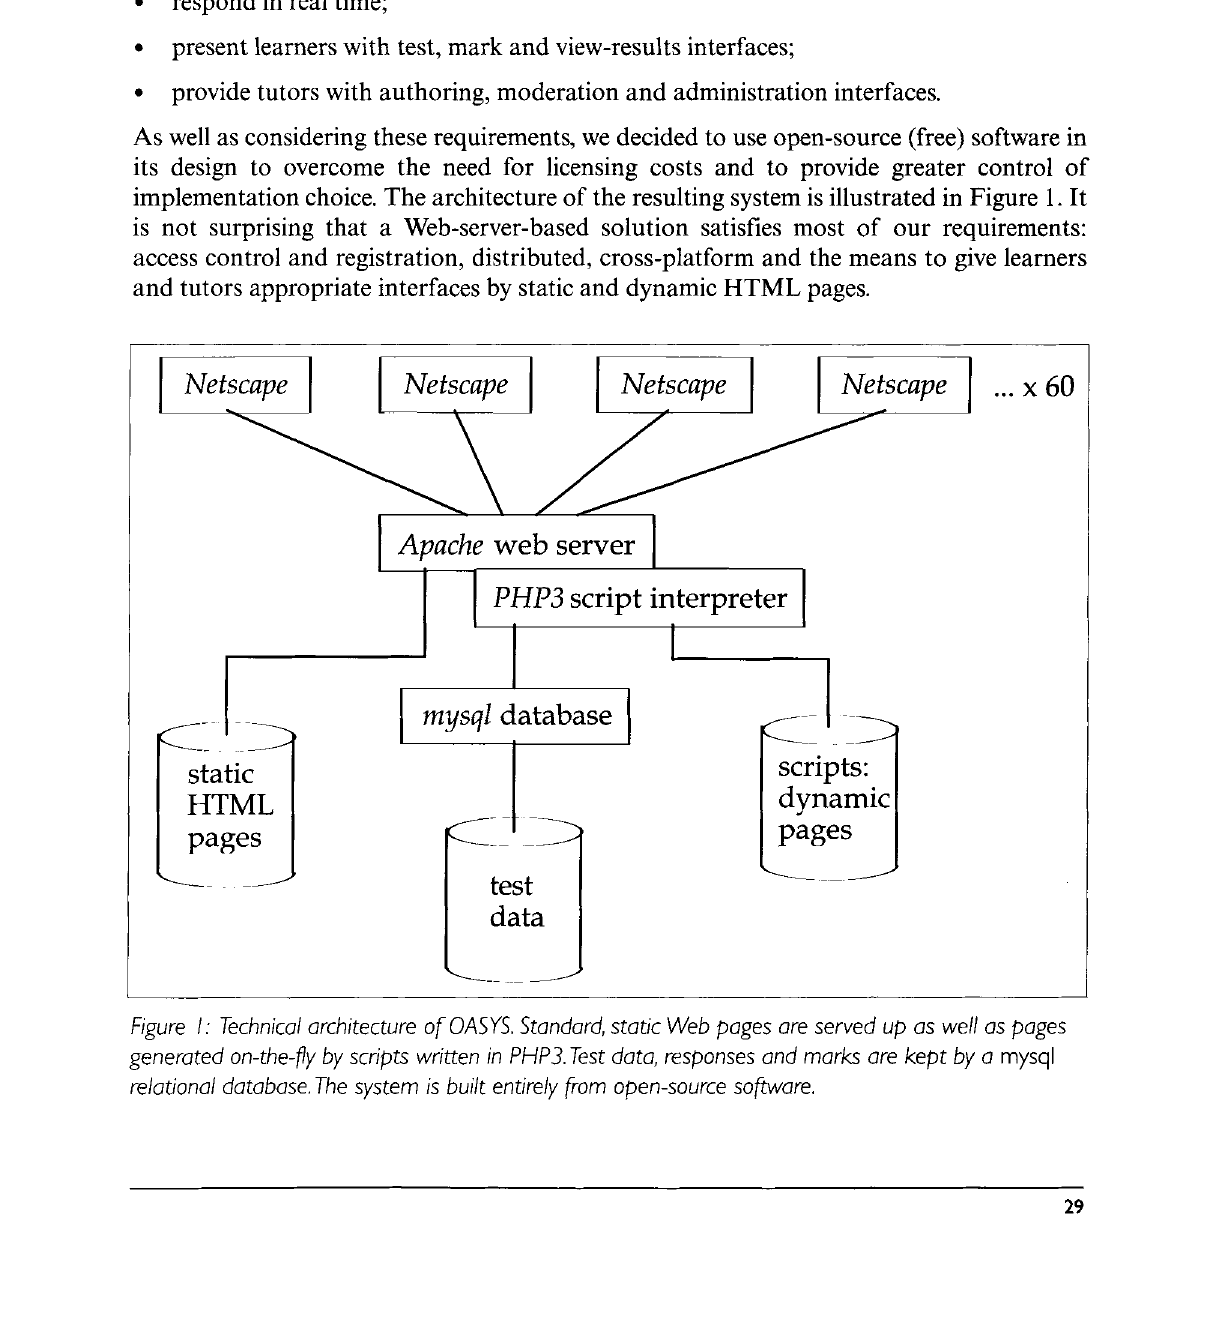
Figure I: Technical architecture of OASYS. Standard, static Web pages are served up as well as pages generated on-the-fly by scripts written in PHP3. Test data, responses and marks are kept by a mysql relational database. The system is built entirely from open-source